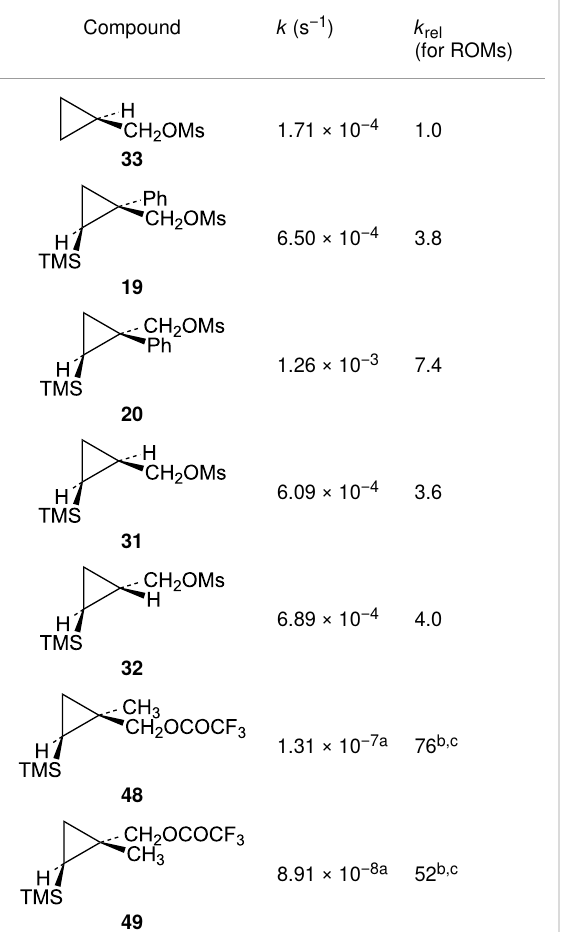
Table 1: Solvolysis rates for substrates in CD 3 CO 2 D at 20.0 °C.